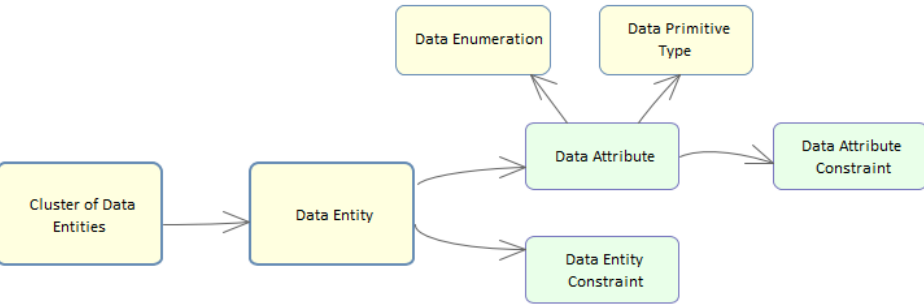
Figure 4. General view of the Data Entities’ linguistic patterns (Mind Map notation).